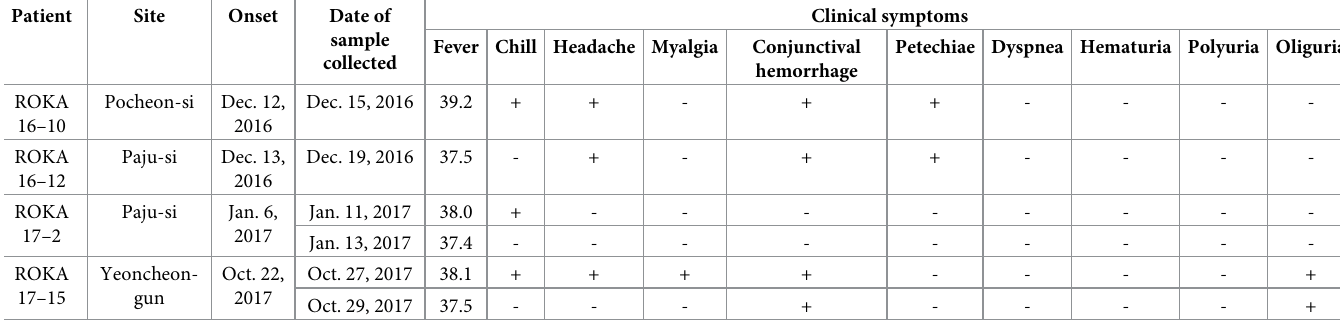
Table 2. Epidemiologic and clinical characteristics of hemorrhagic fever with renal syndrome (HFRS) patients. Patient Site